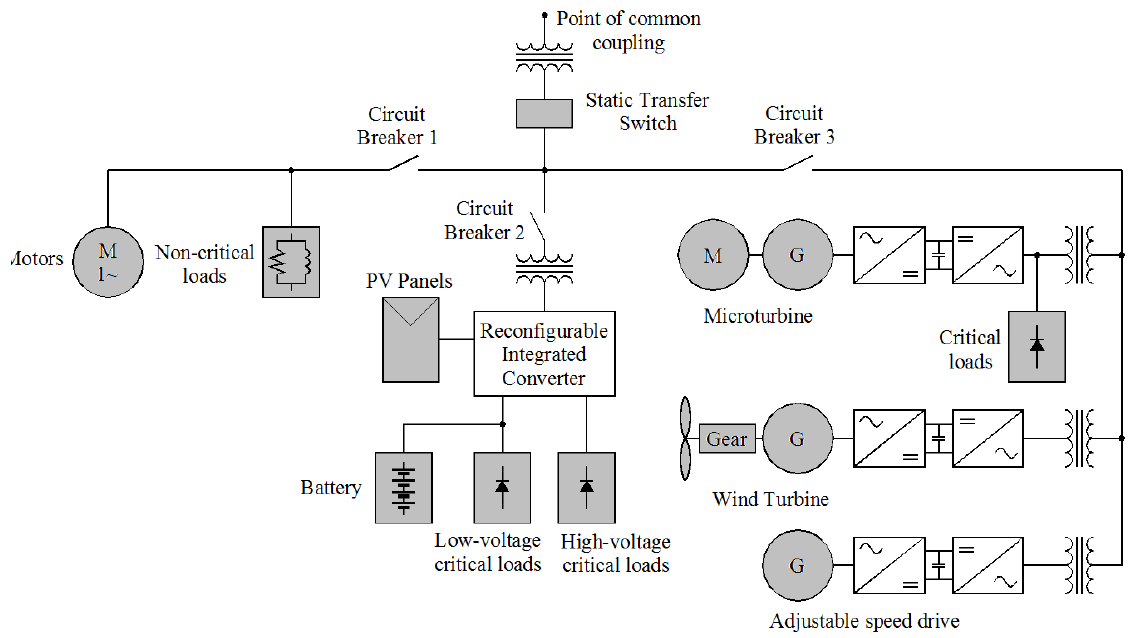
Figure 1. Configuration of a typical AC